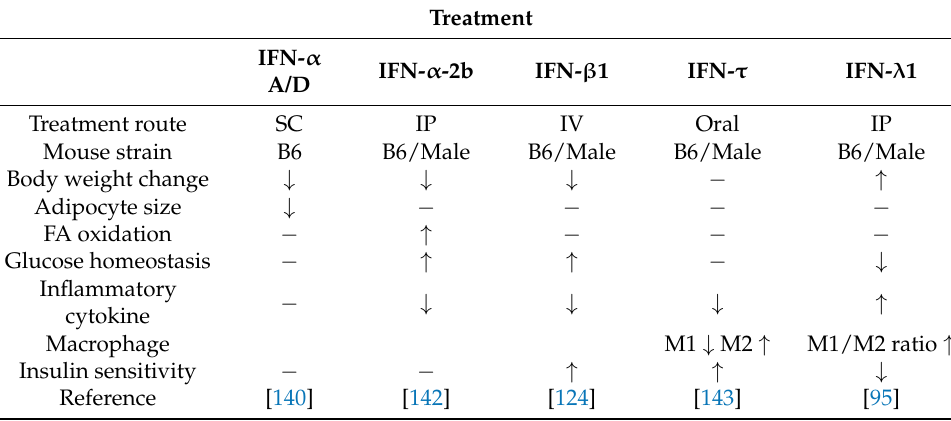
Table 1. The effects of interferon treatment in obese